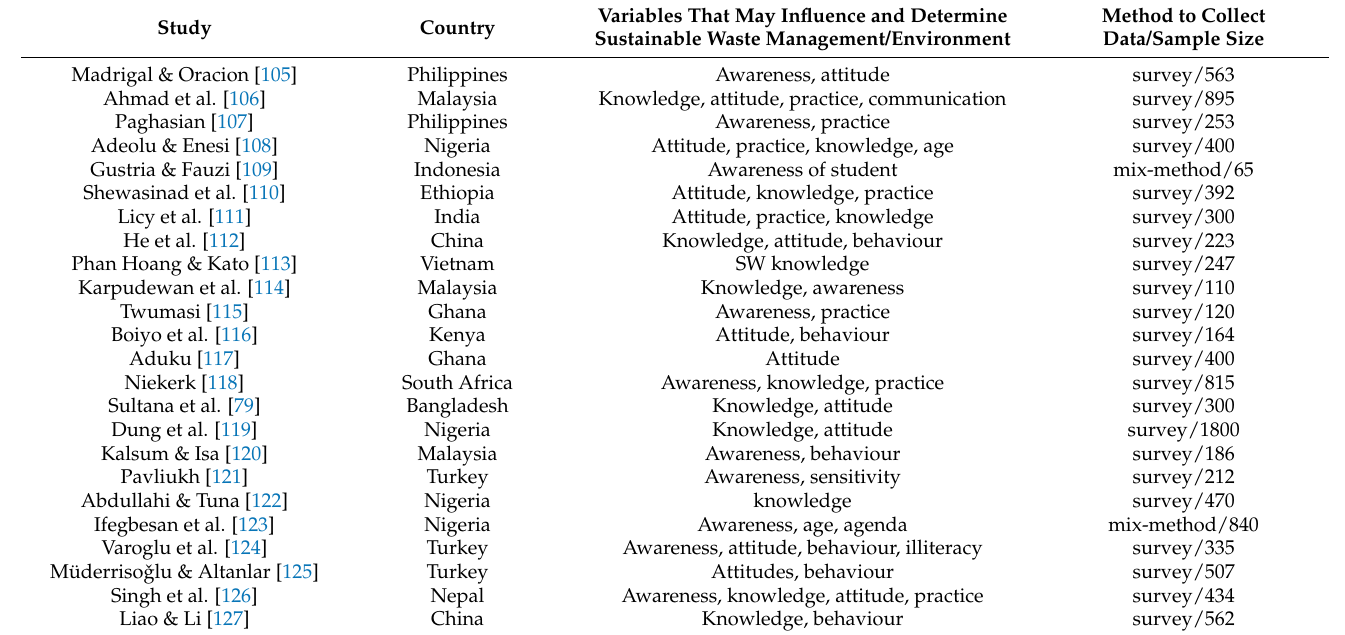
Table 1. Summary of the analysed studies.